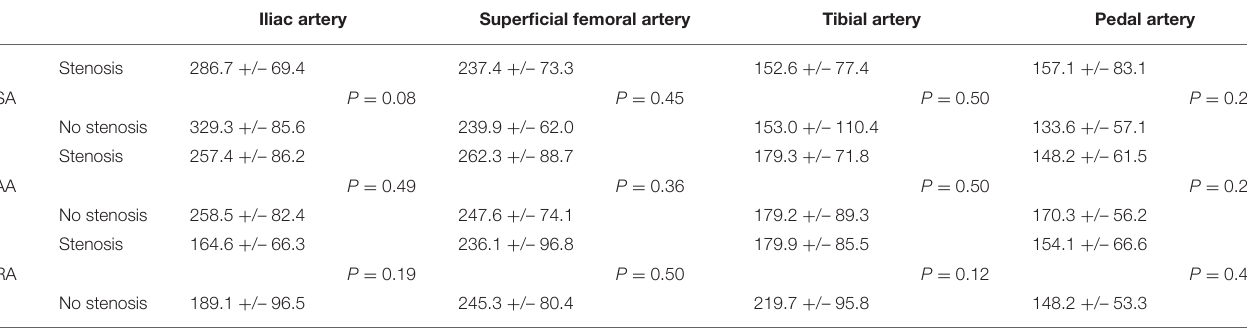
TABLE 3 | Mean attenuation [HU] + /– SD and univariate comparison at the four distal vascular segments stratified by the presence or absence of